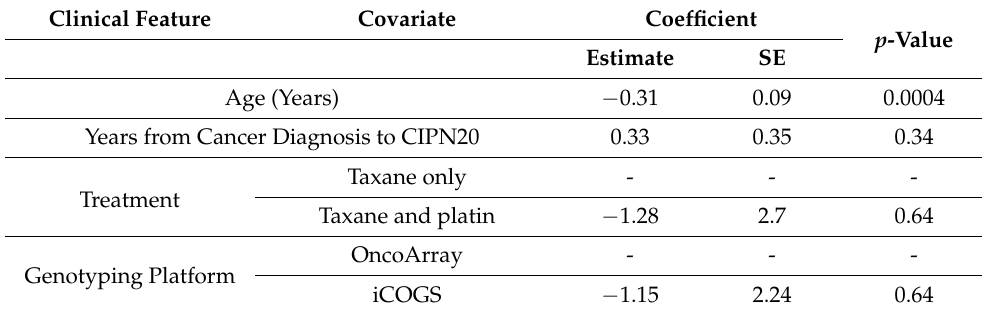
Table 4. Multivariate linear